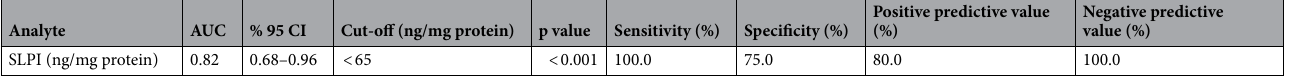
Table 5. AUC and cut-off value for normalized salivary SLPI levels to identify periodontitis (comparing periodontitis to gingivitis). Positive and negative predictive values were given as percentage and p values are calculated by χ 2 test. AUC area under the curve, CI confidence interval, SLPI secretory leukocyte protease inhibitor, ng nanogram, mg